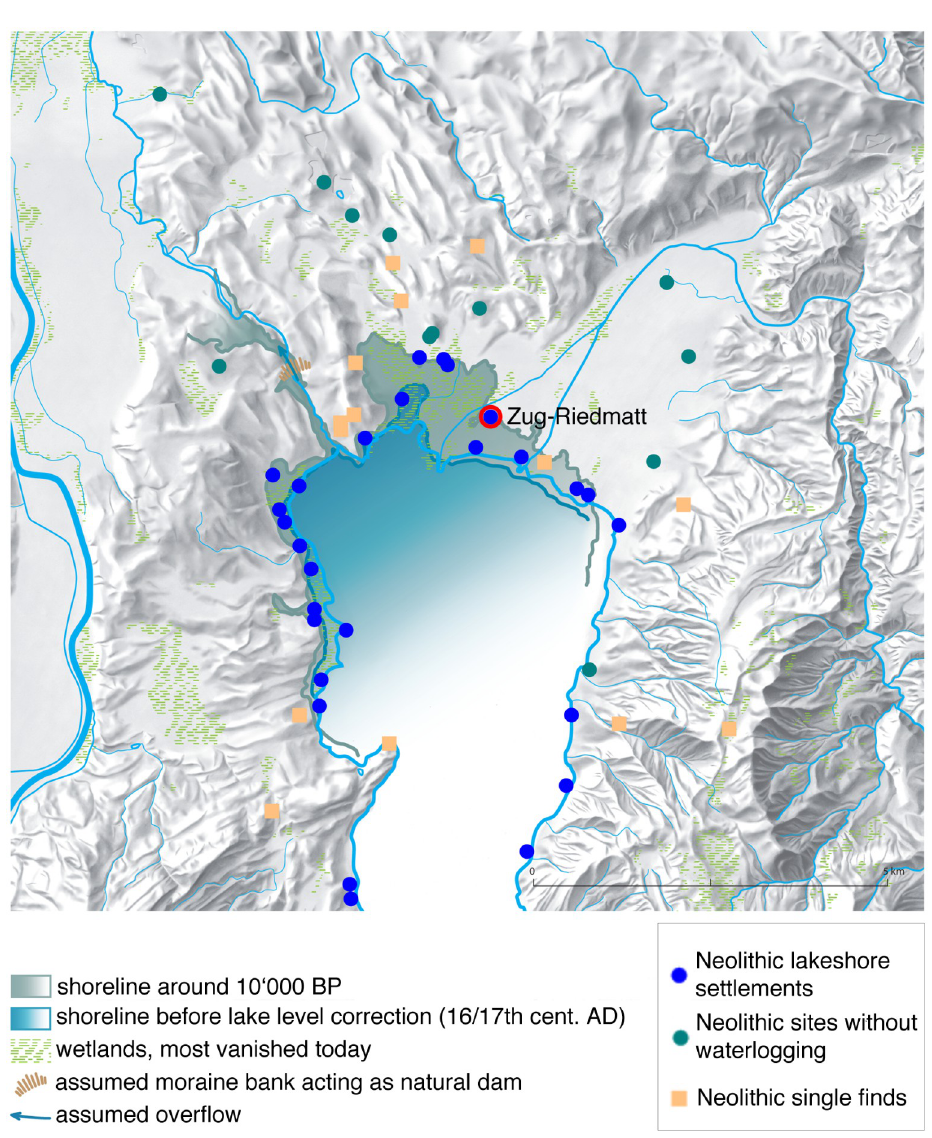
Fig 2. Position of Zug-Riedmatt along the shore of Lake Zug. Published under a CC BY license, with permission from Amt fu¨r Denkmalpflege und Archa¨ologie, Zug (Eva Kla¨ui, Salvatore Pungitore, Eda Gross, Renata Huber), original copyright